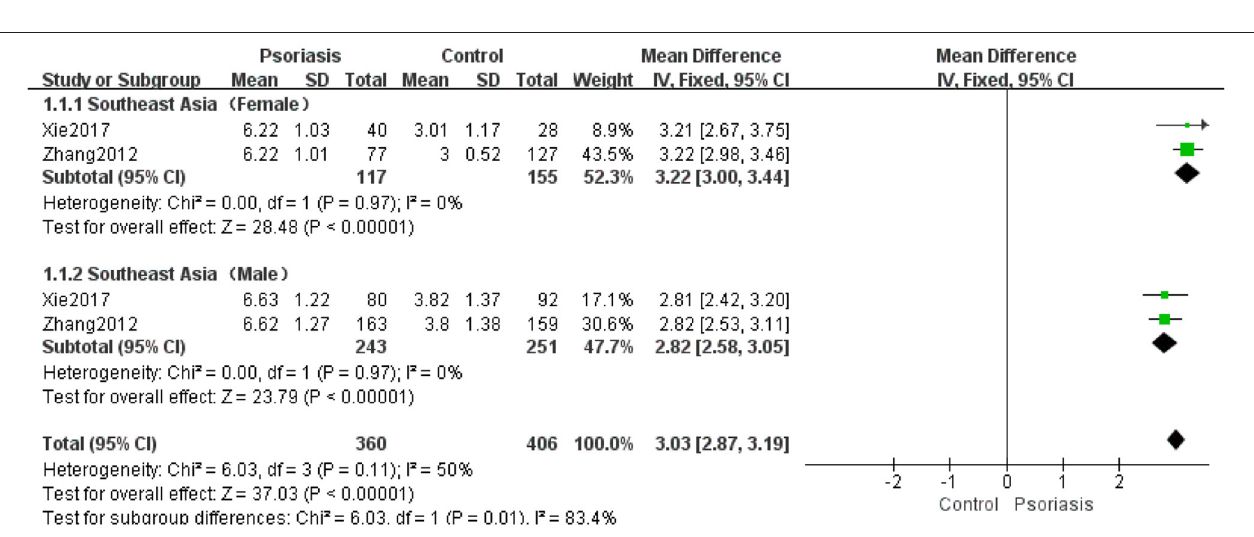
FIGURE 6 | Meta-analysis of the SUA levels of psoriasis patients vs. controls by sex. The MD in SUA levels of psoriasis patients with different genders vs. controls. The point estimate (center of each green square) and statistical size (proportional area of the square) are represented. The horizontal lines indicate the 95% confidence intervals. The subtotal and total MD (diamond) were calculated using a fixed-effects model. MD, mean difference; SUA, serum uric acid.